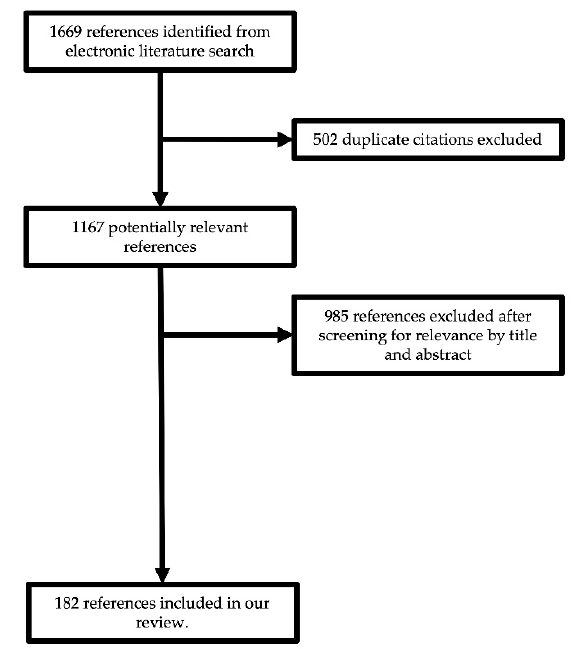
Figure 1. Study selection flow diagram.